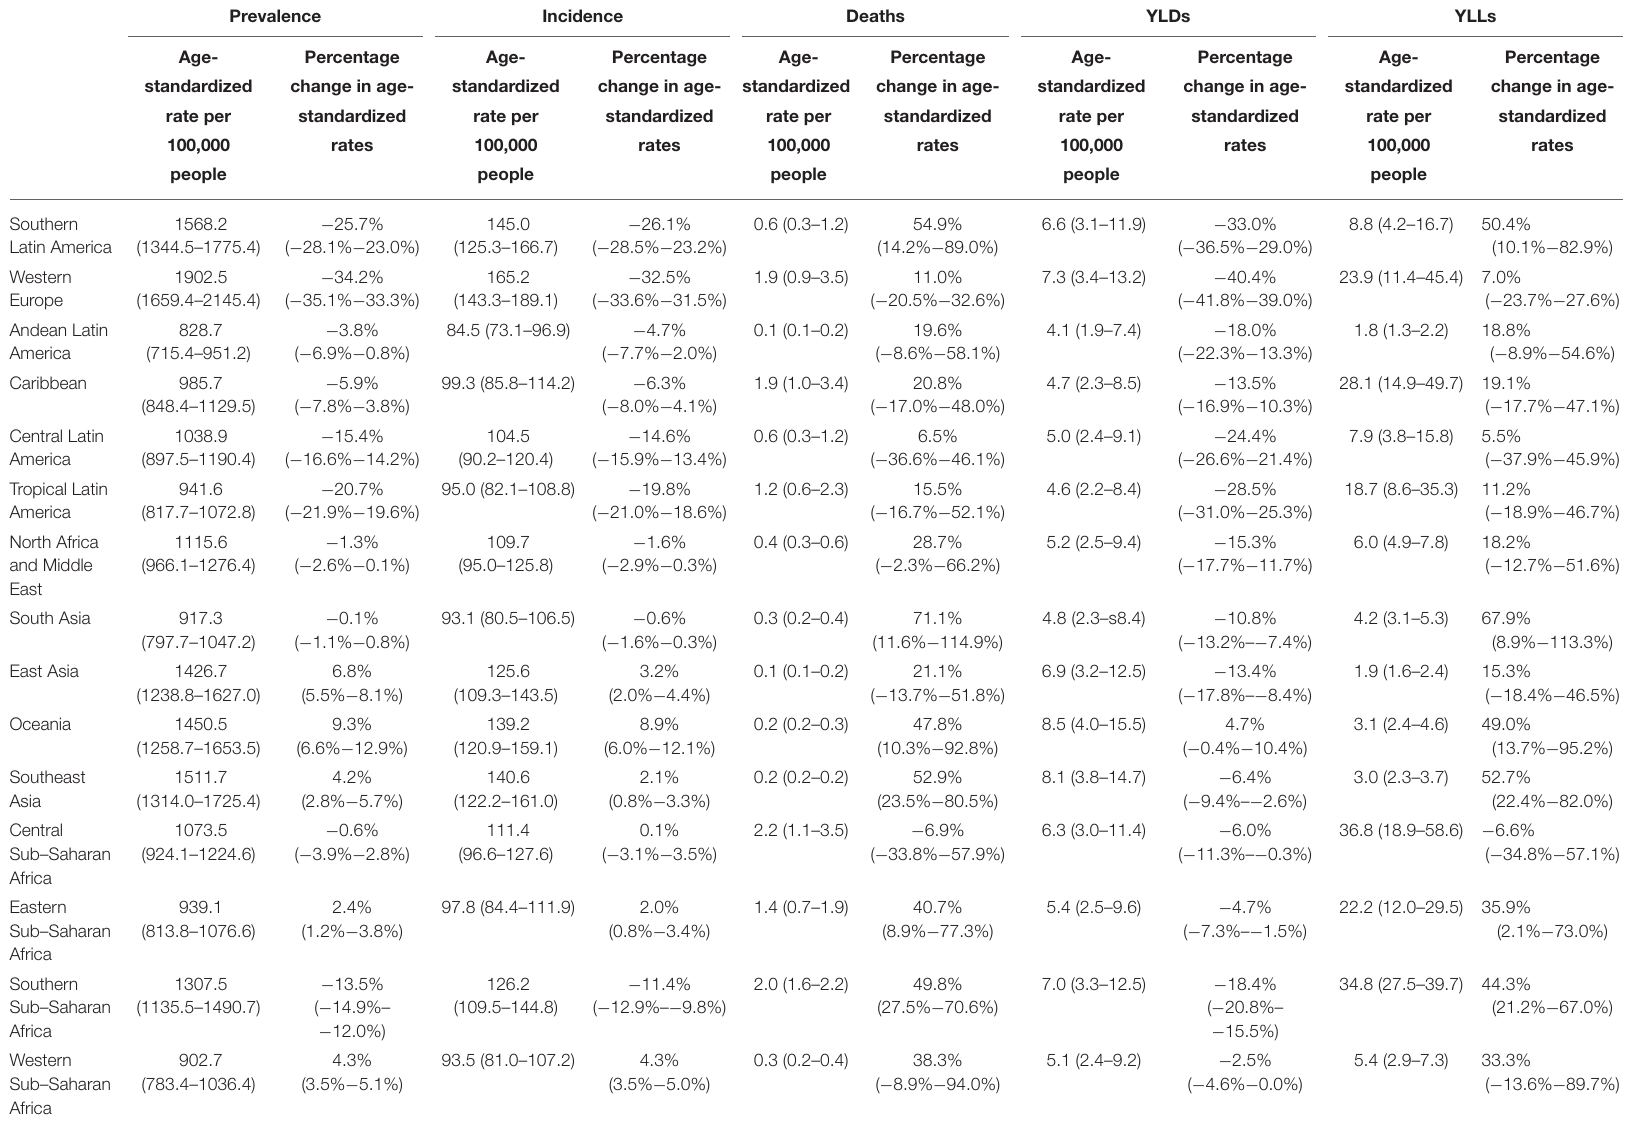
Data in parentheses are 95% uncertainty intervals. GBD, Global Burden of Disease, Injuries, and Risk Factors Study; SDI, socio–demographic index; YLDs, years lived with disability; YLLs, years of life